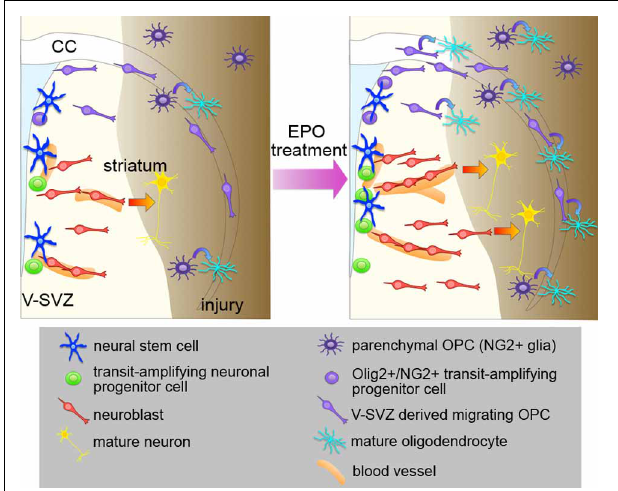
FIGURE 1 | Effects of EPO treatment on the V-SVZ after brain injury. Schematic representation of the effects of EPO treatment on neurogenesis, oligodendrogenesis, and angiogenesis in the brain after injury. EPO treatment enhances the proliferation of NSCs and neuronal progenitors to increase the number of neuroblasts after injury, and promotes recruitment of the neuroblasts to the injured area, where they differentiate into mature neurons. EPO treatment increases the production of migrating OPCs from the Olig2+/NG2+ transit-amplifying progenitors in the V-SVZ, and promotes the differentiation of V-SVZ-derived OPCs into oligodendrocytes in the injured area. The proliferation and differentiation of the parenchymal OPCs are also enhanced by EPO. EPO also enhances angiogenesis, which might be involved in the EPO-induced neurogenesis and oligodendrogenesis after